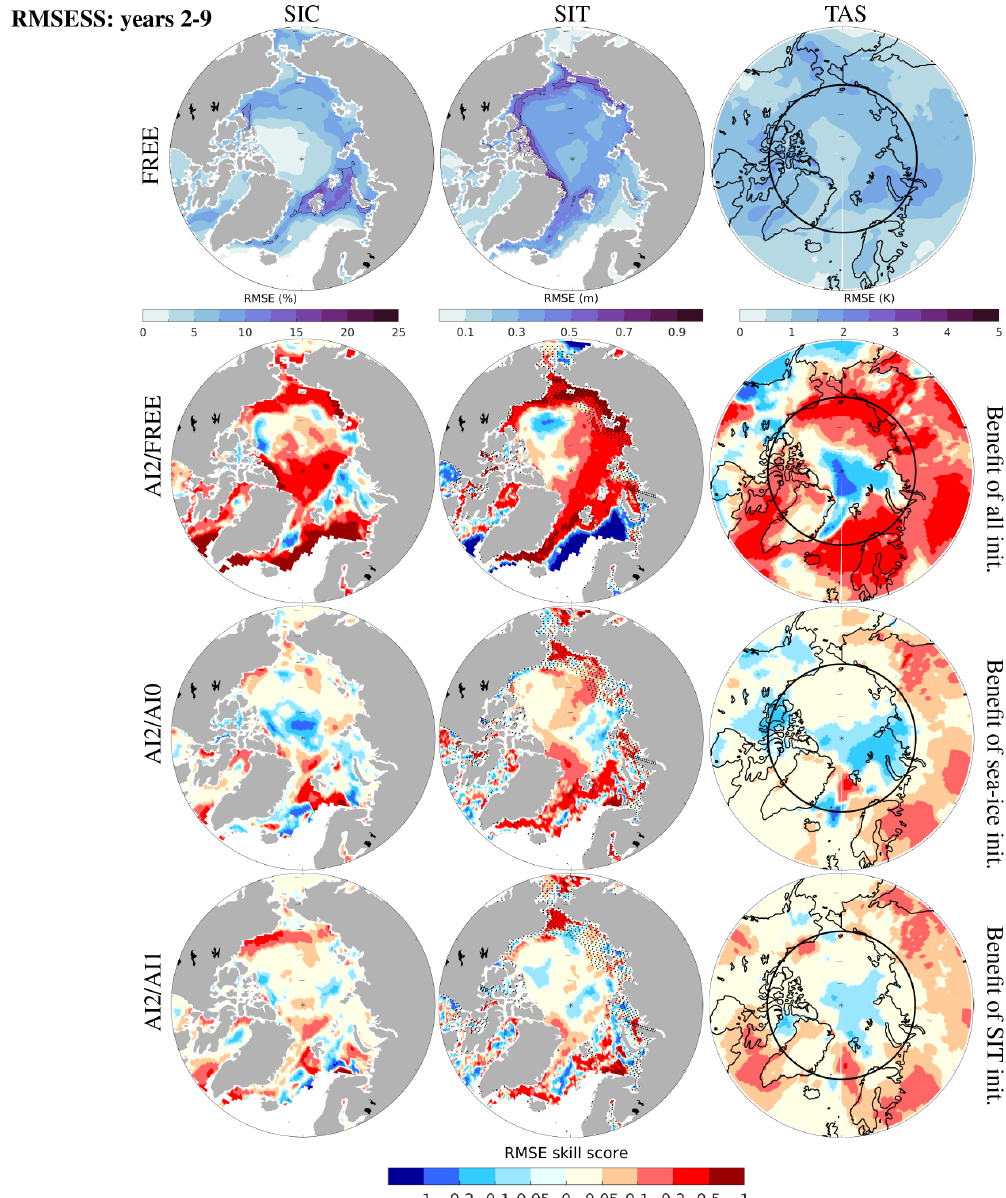
Figure 9. Same as Fig. 6 but for years